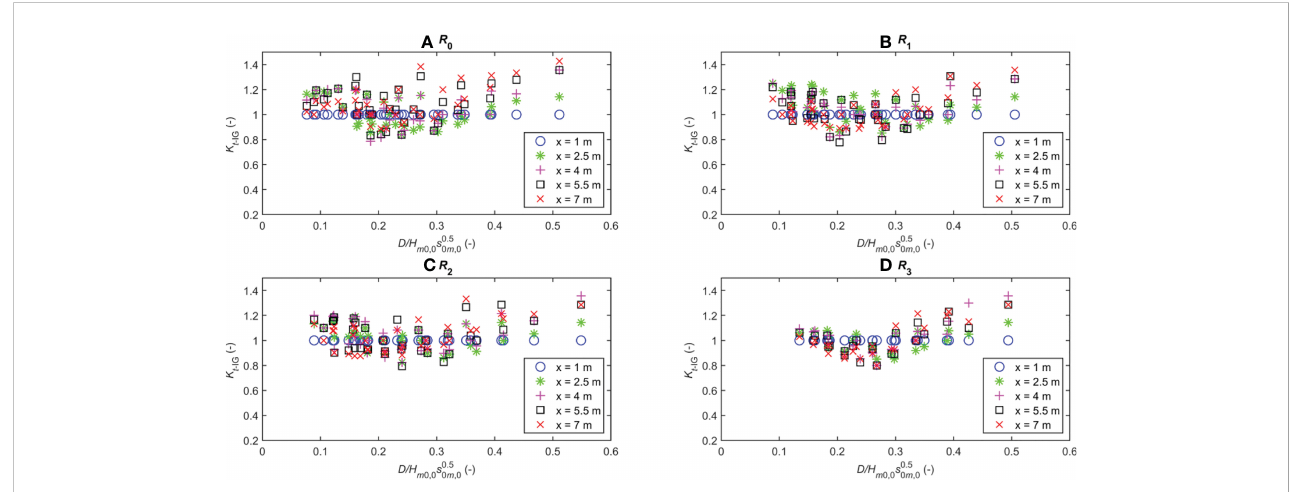
FIGURE 6 Transmission coef fi cient K t-IG versus relative submergence for IG-waves: (A) Smooth reef; (B) Crushed stone reef 1; (C) Crushed stone reef 2; (D) Simulated coral reef.